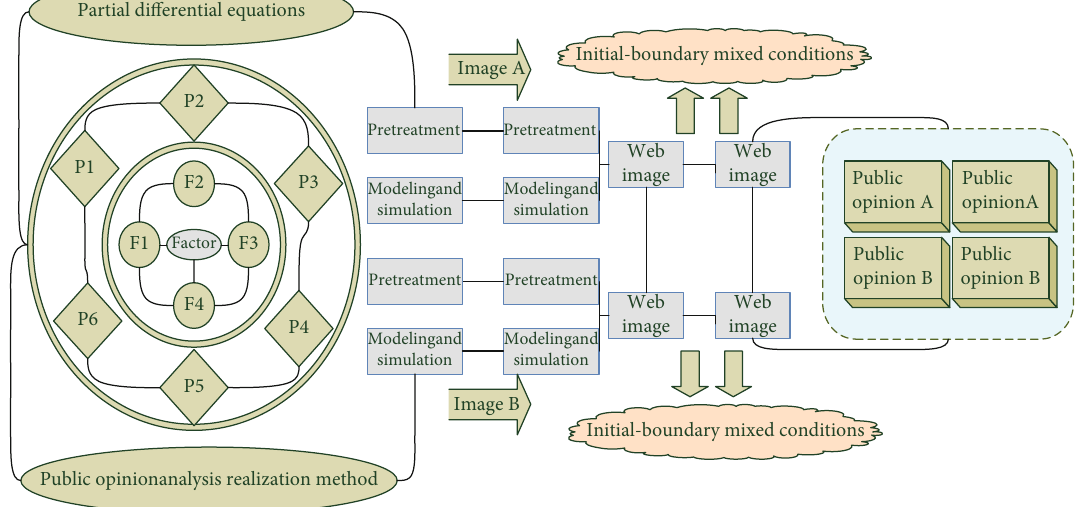
Figure 1: The spatial distribution level of the solution set of partial di ff erential